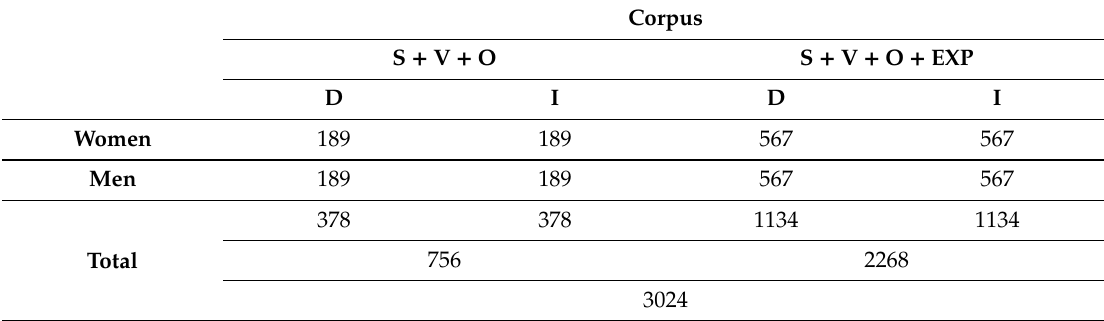
Table 2. Corpus selected for the dialectometric